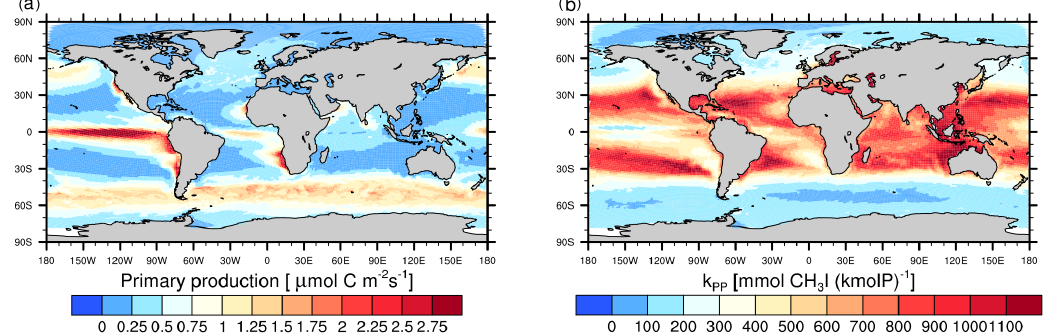
Figure 4. Integrated annual mean primary production (µmolm − 2 s − 1 ) (a) and mean ratio between methyl iodide and primary production rate k PP (mmolCH 3 I ( kmolP ) − 1 ) (b) .